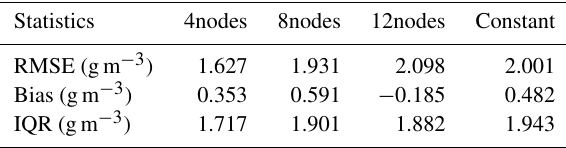
Table 1. Prime number decomposition access order. Table 2. Statistics showing the differences between the four schemes and water vapor measurements constructed by HKKP’s ra- diosonde data for 7 days (DOY 221–227) in